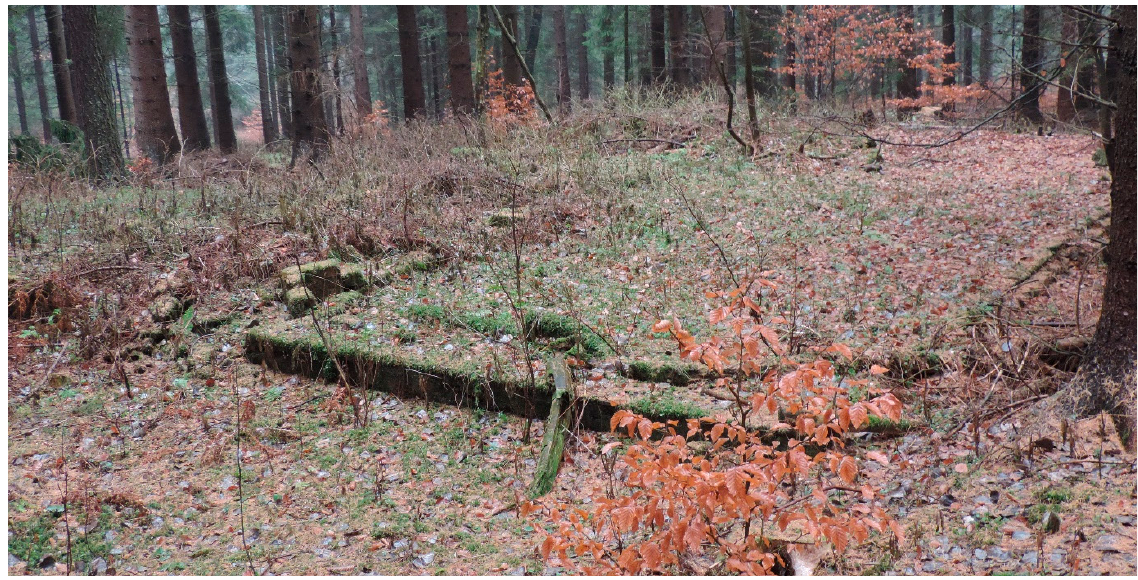
Figure 13. Remains of the barrack’s foundation, AL Säuferwasser; photo P. Bylina.